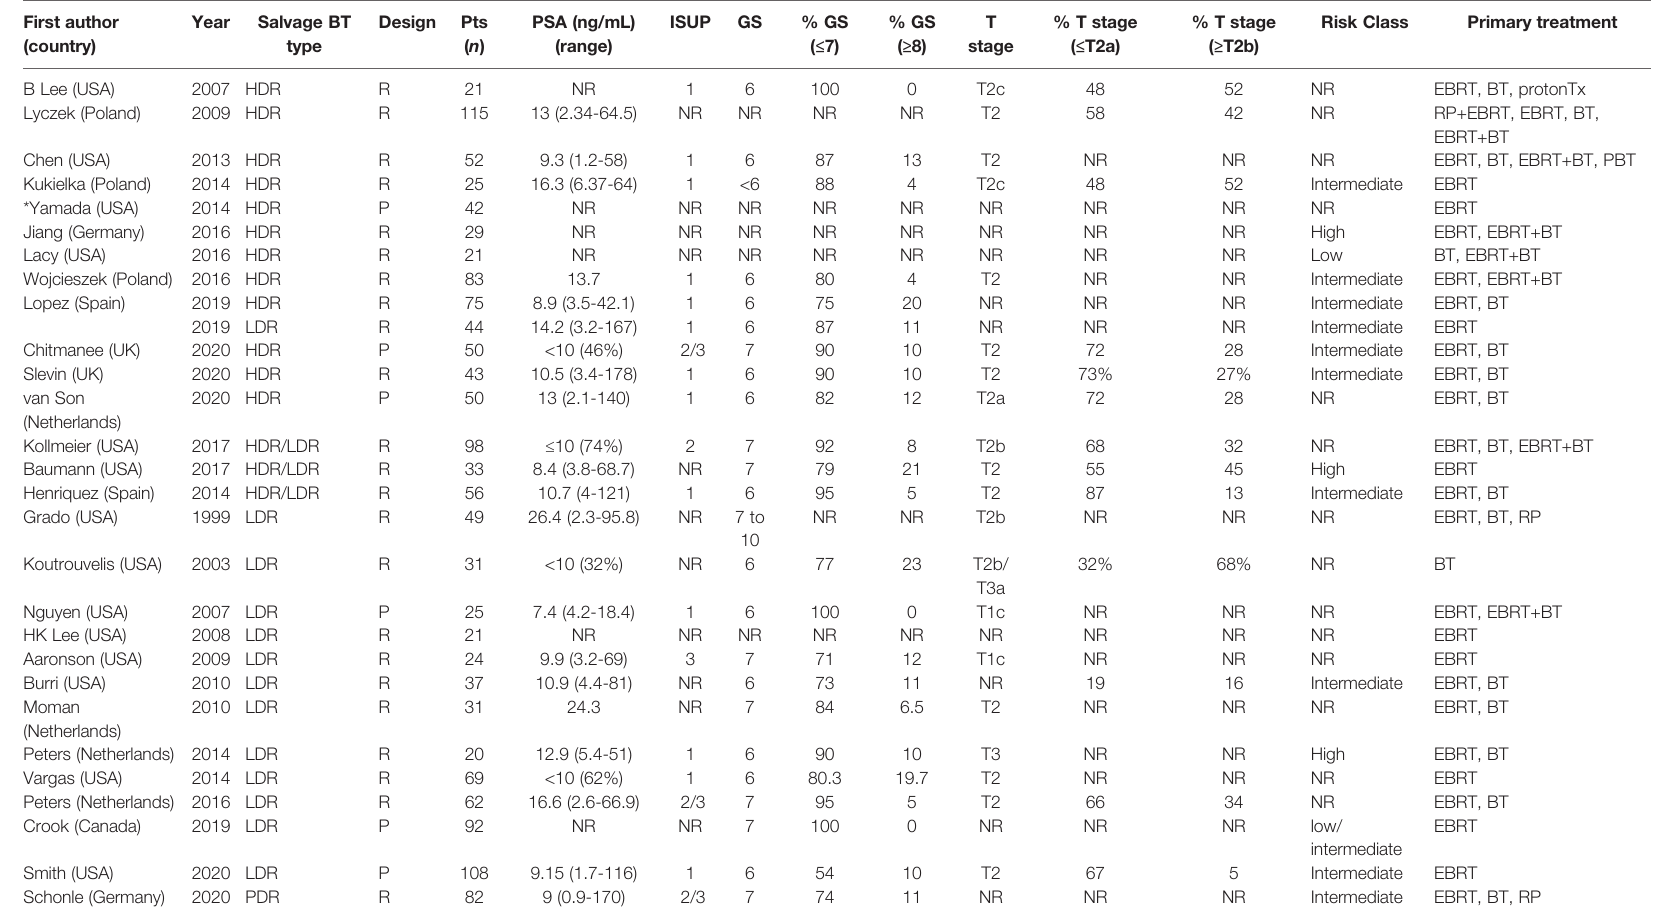
TABLE 2 | Primary disease and treatment characteristics for brachytherapy